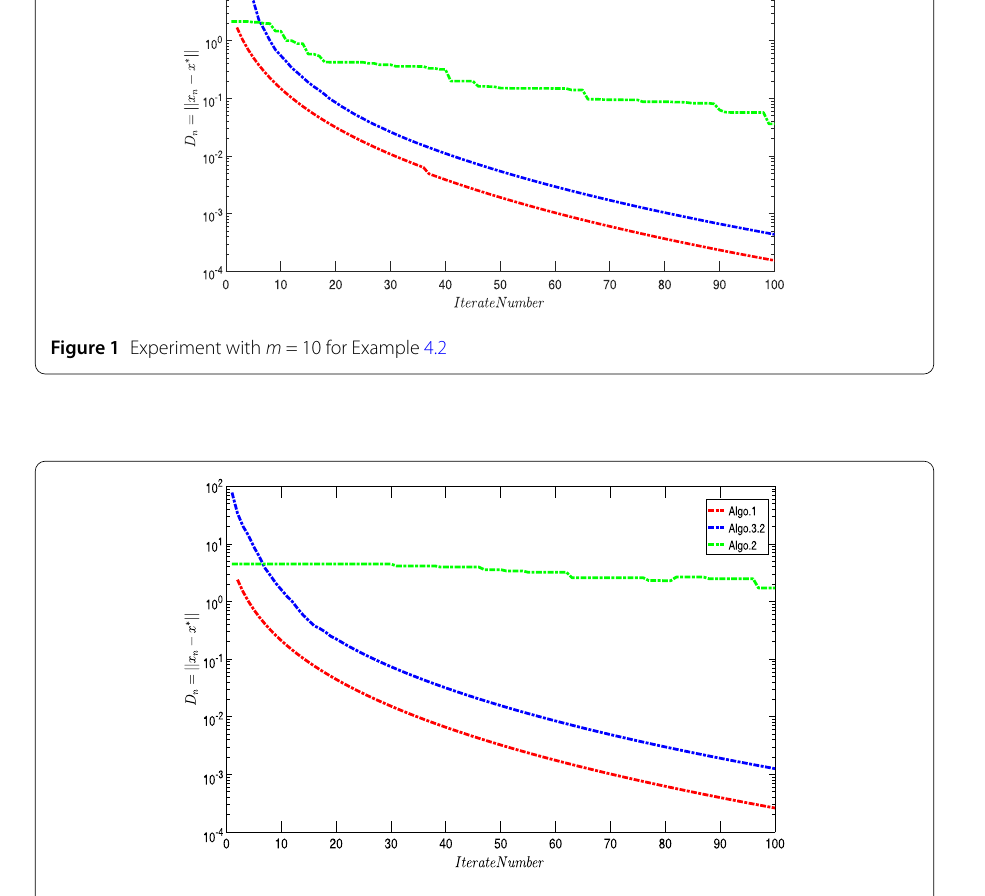
Figure 2 Experiment with m = 20 for Example